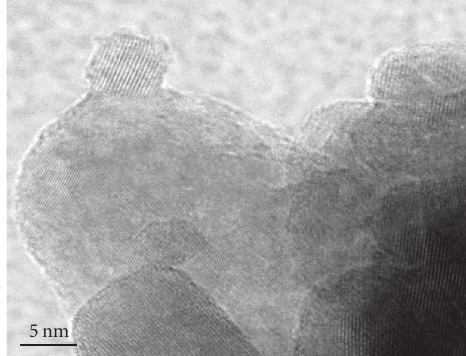
Figure 4: Trasmission electron microgaph of the R100 TiO 2 cata- lyst.